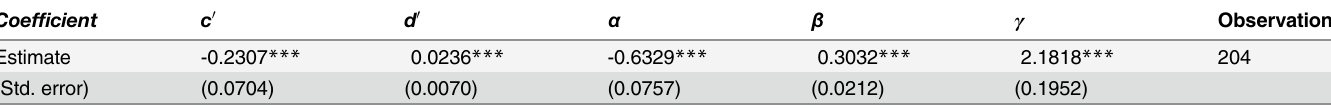
Table 1. Multi-Agent Model Estimation